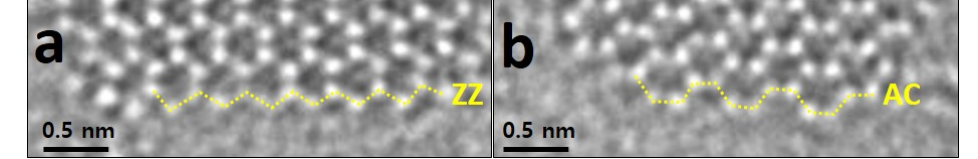
Figure 2. Edge configurations of g-ZnO. ( a ) ZZ edge configuration and ( b ) AC edge configuration. In order to stabilize the edge of the synthetic g-ZnO sheet, but not the ZnO thinned from the bulky wurtzite ZnO, adatoms can be absorbed at the edge of the g-ZnO sheet. We observed that adatoms migrate along the edge of the ZnO sheet before being com- pletely absorbed into the sheet (Figure 3). Although the migrating atoms at the edge might be carbons from carbon adsorbates and the graphene sheet, it is more likely that Zn atoms migrate because the Zn atom is clearly larger than the C. In addition, the positions in which the moving atoms settled are between O atoms designated at the O-terminated ZZ edge, which is confirmed using a line profile (as shown in Figure S1). Adatoms, colored with yellow dots, can attach and detach at the edge under continuous electron beam irra-